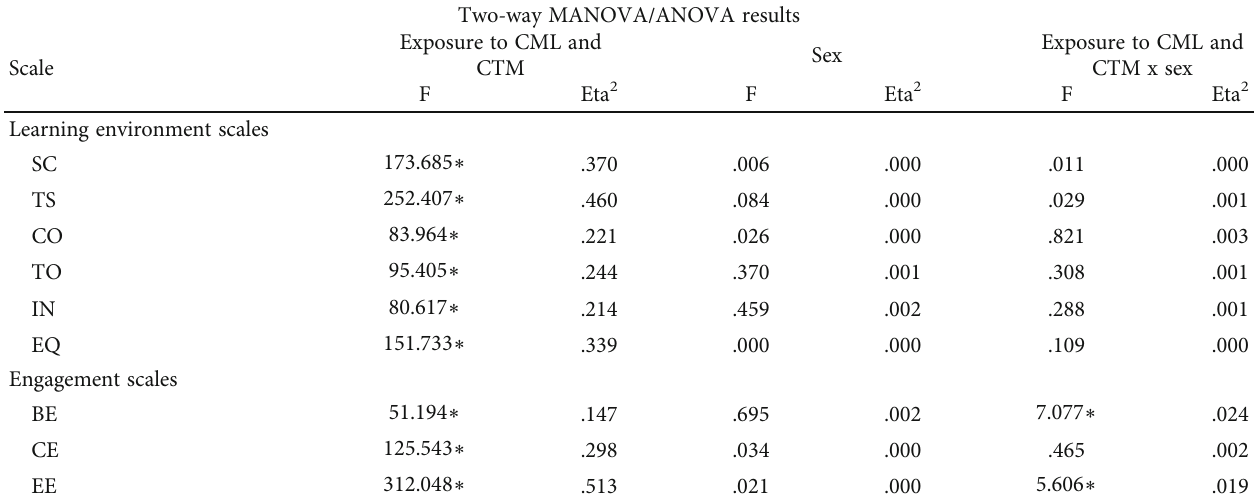
Table 5: Two-way MANOVA/ANOVA results for CML and CTM groups and gender for each classroom learning environment and engagement scales.